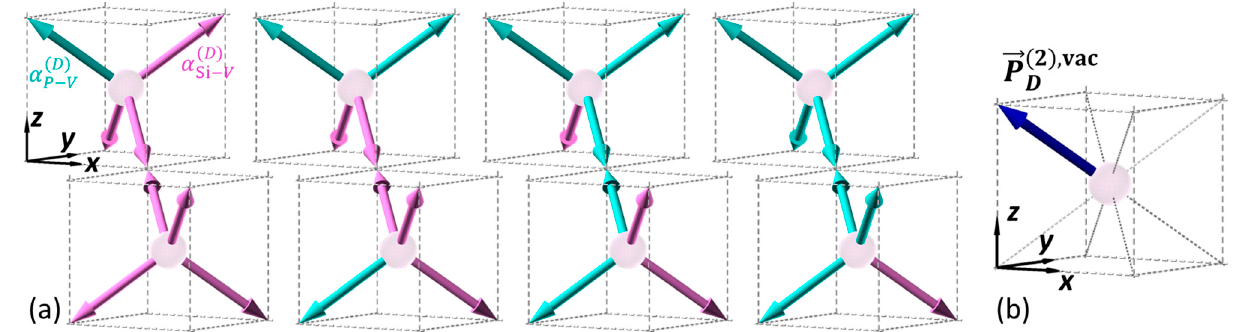
Figure 4. ( a ) Cases of the bond vector structure in a vacancy cell pair that provides the same ( b ) dipolar SHG polarization along a bond.